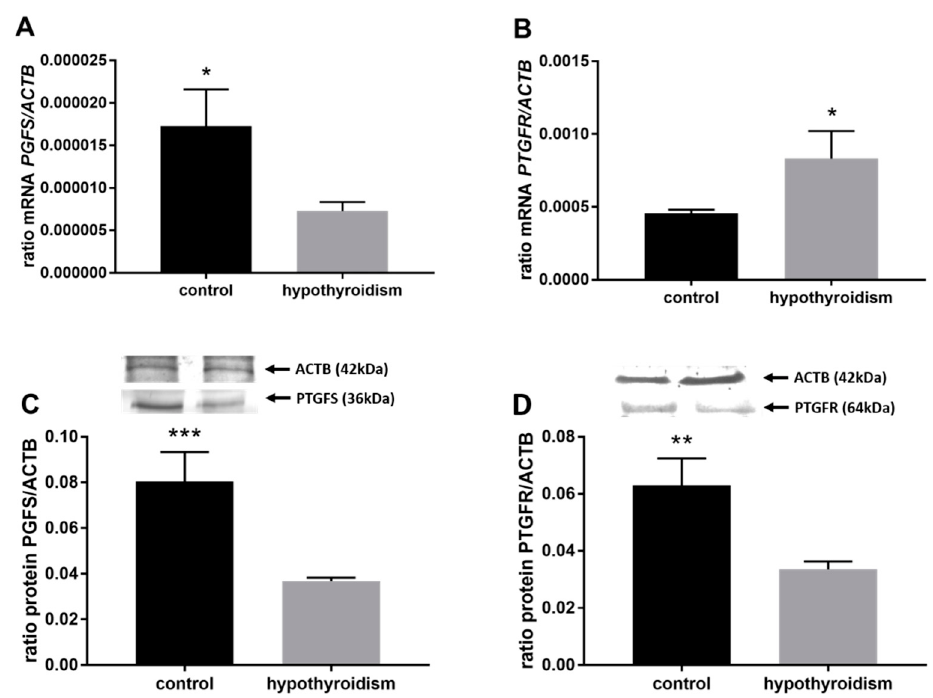
Figure 7. The effects of hypothyroidism on the mRNA and protein abundance of PGF 2 α synthase and its receptor in the uterine tissue of rats: ( A , C ): PGFS/PGFS; ( B , D ): PTGFR/PTGFR. The values are presented in arbitrary units and expressed as the mean ± SEM. Stars indicate significant differences (* p ≤ 0.05, ** p ≤ 0.01, *** p ≤ 0.001, **** p ≤ 0.0001), as determined by Student’s t -test.